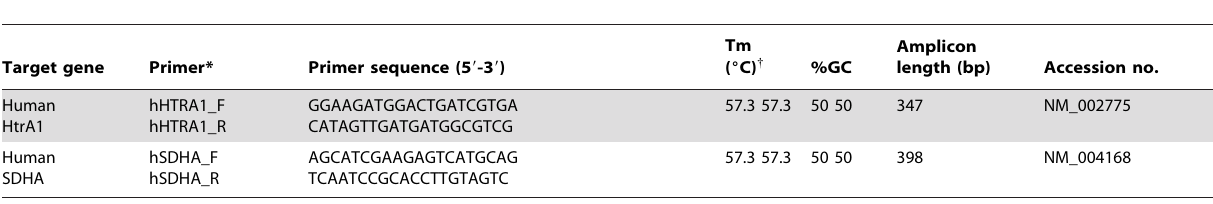
Table 2. Characteristics of the primers used for SYBR green Q-PCR assays.